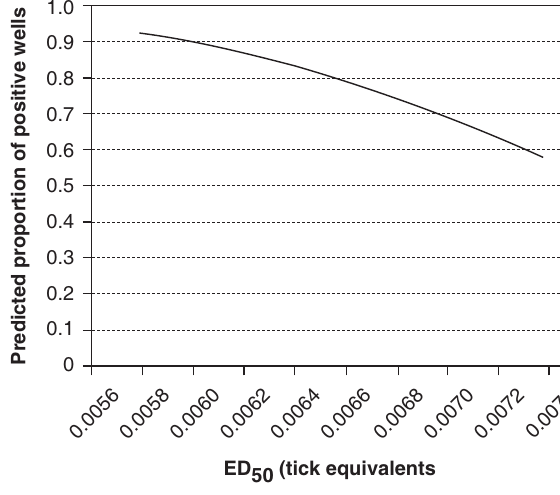
FIG. 4 Correlation between proportions of protected animals against in vitro ED